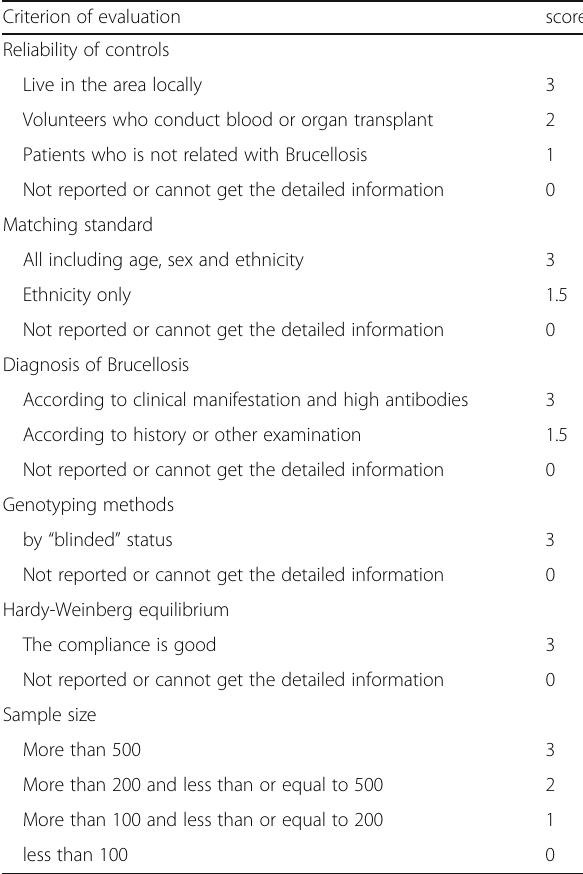
Table 1 Detailed evaluation criteria focused on included